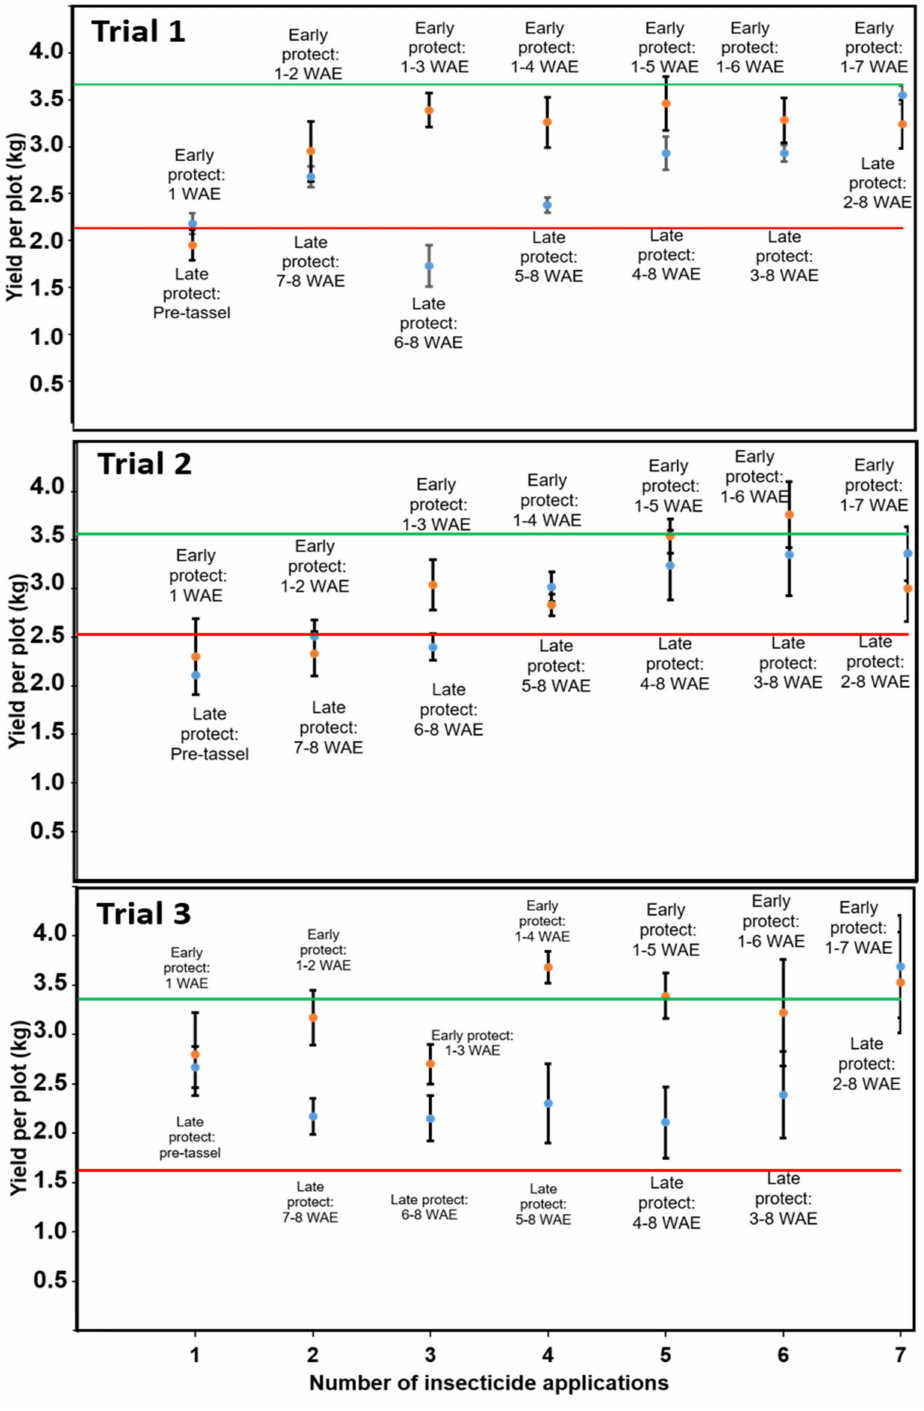
Figure 1. Mean yield per plot as a function of the number of insecticide sprays applied during the vegetative stages up to the pre-tassel stage of maize. Insecticide applications were completed at various growth stages under high natural Spodoptera frugiperda infestation levels. The first application was completed 1 week after seedling emergence. The green line indicates the mean yield of fully protected plots, while the red line indicates yield of unprotected plots. (Sequence I = blue, Sequence II = orange; bars = standard